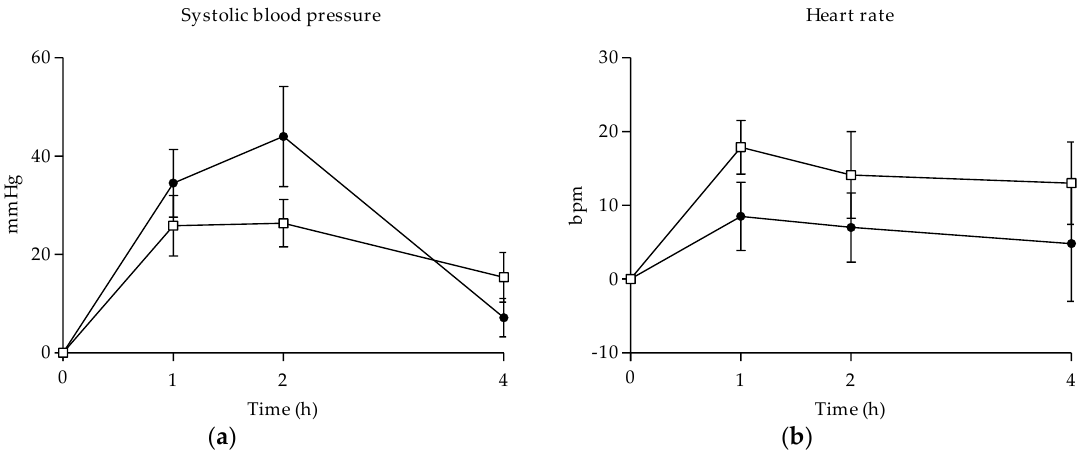
Figure 1. Time course of systolic blood pressure ( a ) and heart rate ( b ) after methylone and MDMA oral administration. ( □, 100 – 300 mg methylone ( n = 8) ; ●, 7 5 – 100 mg MDMA ( n = 6); mean, standard error).